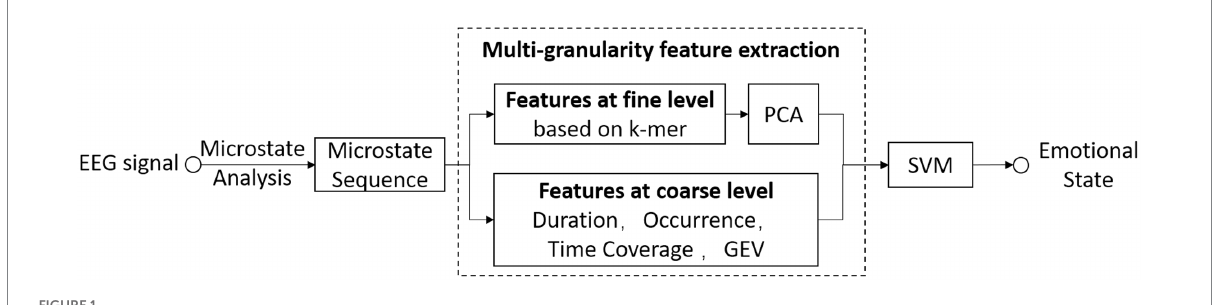
FIGURE 1 The schema of the methodology.